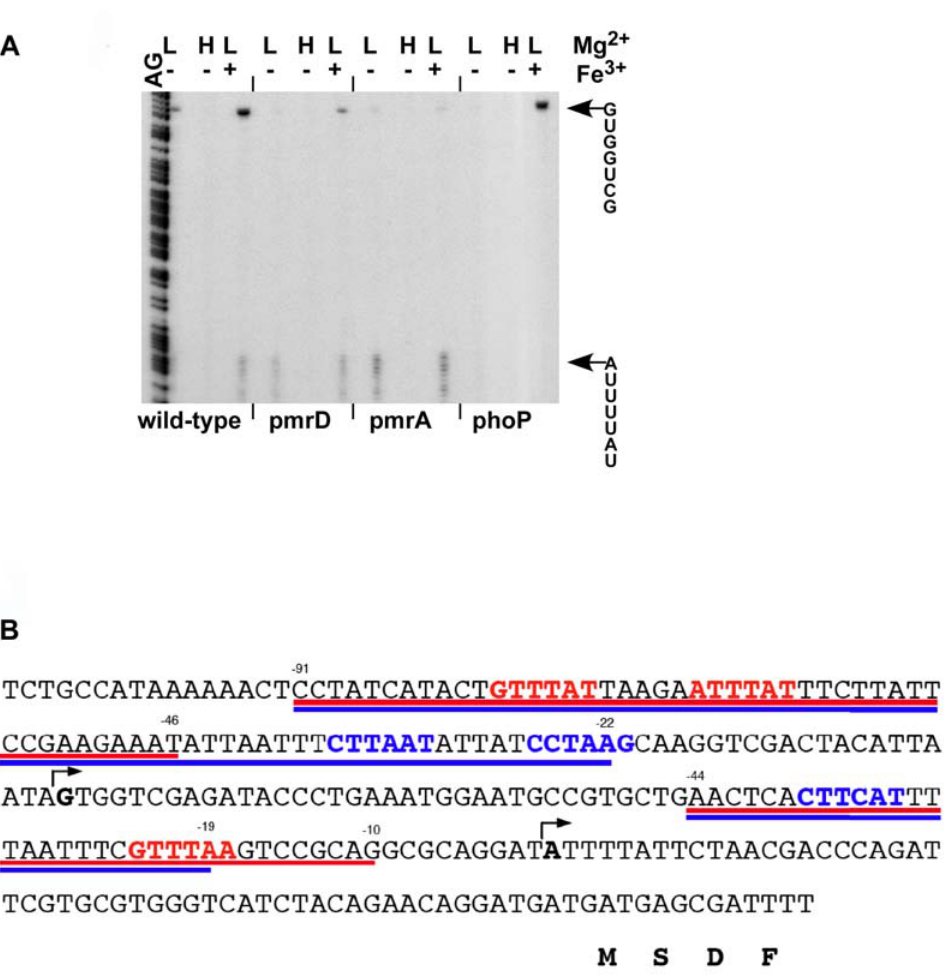
Figure 4. Dependence of pbgP transcription on the pmrA , pmrD , and phoP genes under different growth conditions. (A) S1 nuclease- protection assay of RNAs extracted from bacteria grown at 37 u C in N-minimal medium, pH 7.7, with 10 m M MgCl 2 (L, 2 ), 10 mM MgCl 2 (H, 2 ), or 10 m M MgCl 2 and 100 m M FeSO 4 (L, + ). Lane AG corresponds to the Maxam-Gilbert DNA ladder of the target sequence. The sequences spanning the two transcription start sites are shown, and the start sites are indicated with arrows. (B) DNA sequence of the promoter region of the K. pneumoniae pbgP gene. The two transcription start sites are indicated in bold and with arrows. The sequence in blue resembles the PmrA-box consensus [22], the sequence in red resembles the PhoP-box consensus [22]. The DNA sequence underlined with blue and red indicates the regions footprinted by the S. enterica PmrA and PhoP proteins, respectively (the footprinting data are shown in Figure S3). The first four amino acid residues of the pbgP ORF are indicated below the nucleotide